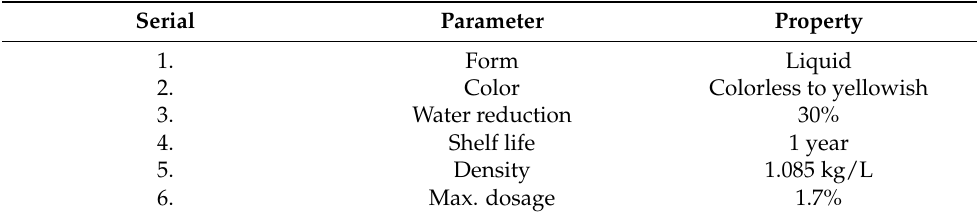
Table 5. Properties of Viscocrete